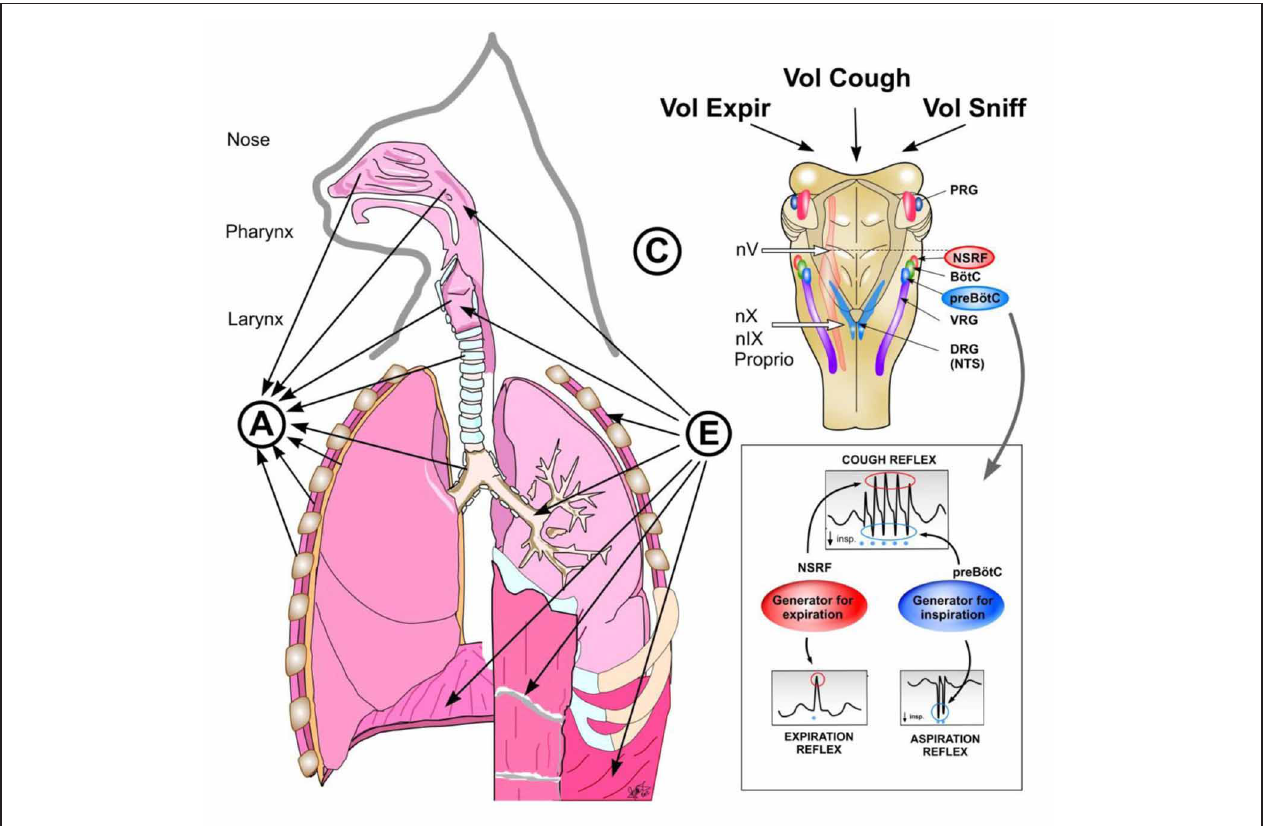
FIGURE 7 | Reflex arch and mechanisms of AspR, ExpR, and CR and their voluntary counterparts. Schematic illustration of reflex arch and mechanisms of AspR, ExpR, and CR and their voluntary counterparts. A—afferents via trigeminal nerve from the upper part of nasal cavity for sniffing, via n. glosso-pharyngicus from the nasopharynx for AspR, via n. laryngicus sup. from the larynx for ExpR and via n. vagus from tracheal-bronchial region and proprioceptive afferents for CR. E—efferents to